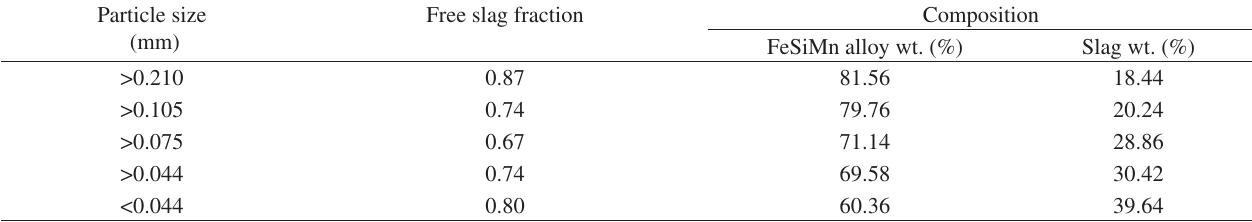
Table 3. Quantitative analysis of FeSiMn fines for slag and alloy content and the slag liberation fractions as a function of particle size. Particle